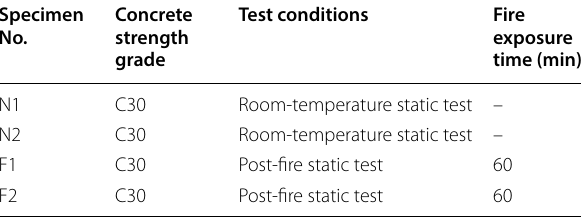
Table 3 Basic parameters of specimens Specimen No.